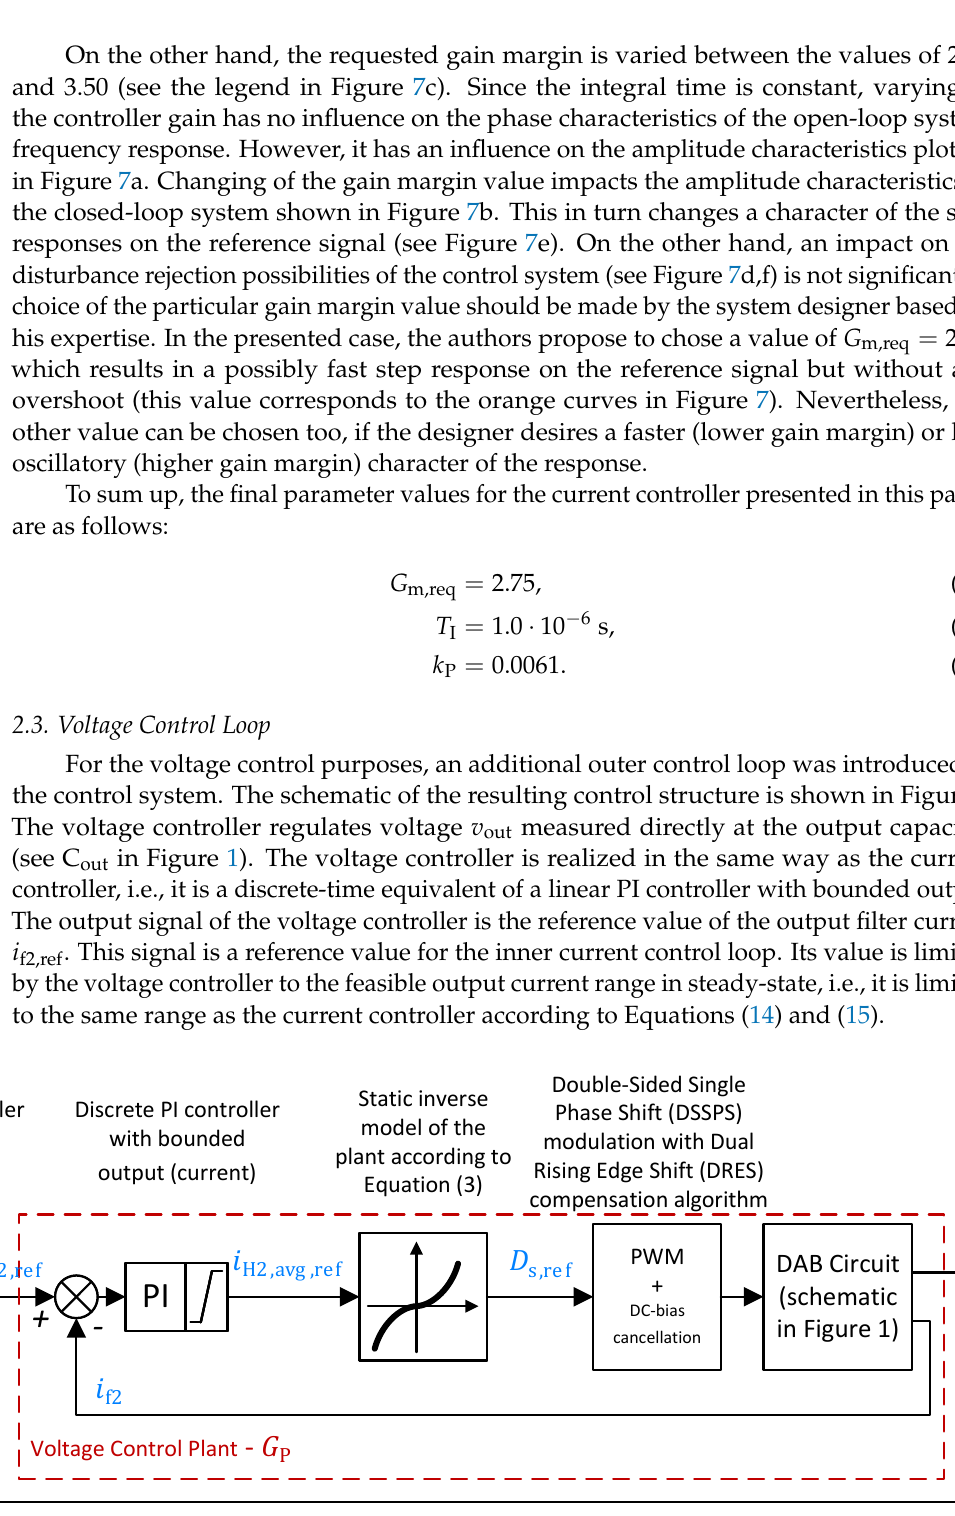
Figure 8. Schematic of the cascaded voltage and current control